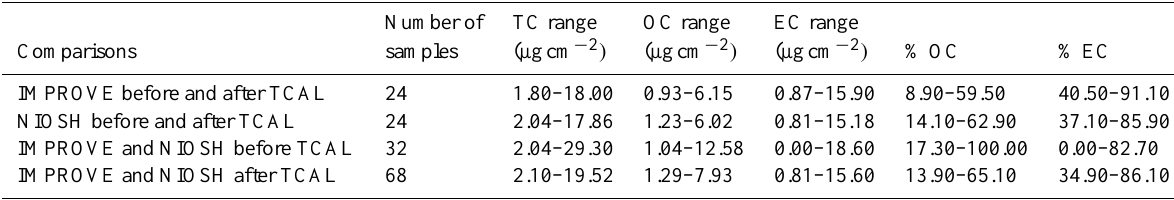
Table 1. Summary of laboratory test